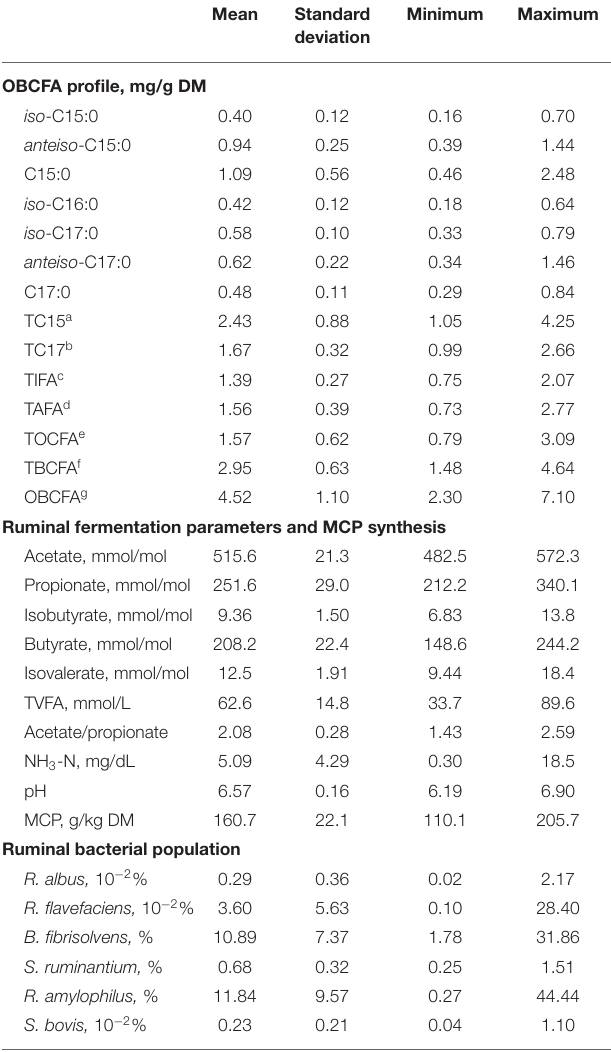
TABLE 6 | Summary statistics of variables utilized for the correlation analysis. Mean Standard Minimum deviation